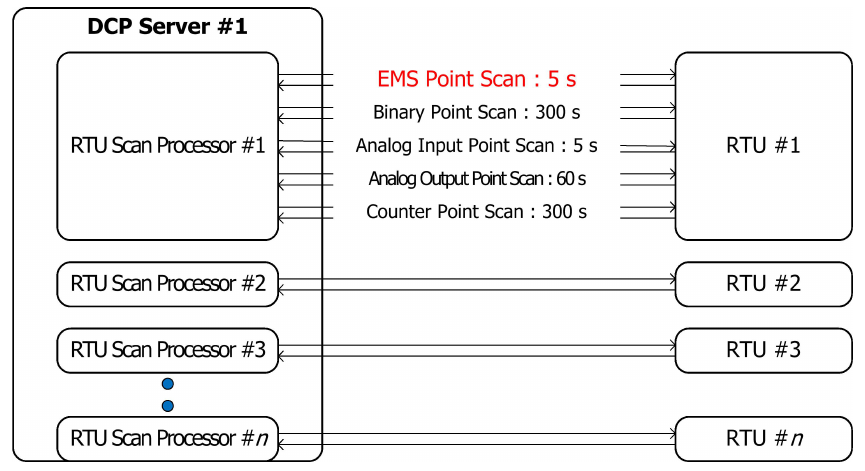
Figure 7. RTU scan processor of DCP for synchronized data acquisition.